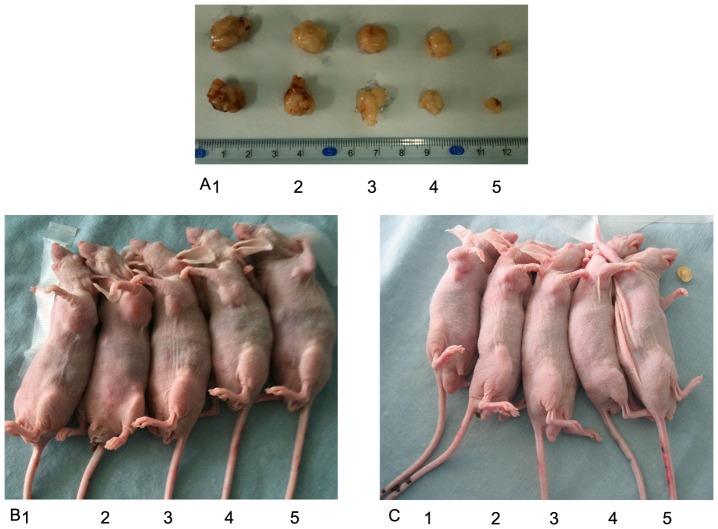
Subcutaneous xenografts of nude mice in different treatment groups.A: isolated tumors of SGC7901 cells (above) and SGC7901/ADR cells (below) B: subcutaneous xenografts of SGC7901 cell line in nude mice C: subcutaneous xenografts of SGC7901/ADR cell line in nude mice. (group 1): NS control group (group 2): TWEEN control group (group 3): ADR group (group 4): PAB group (group 5): PAB+ADR group.